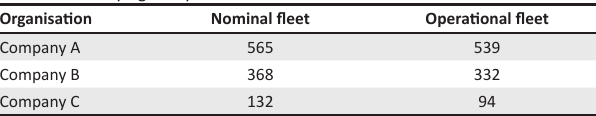
TABLE 3: Qualifying study